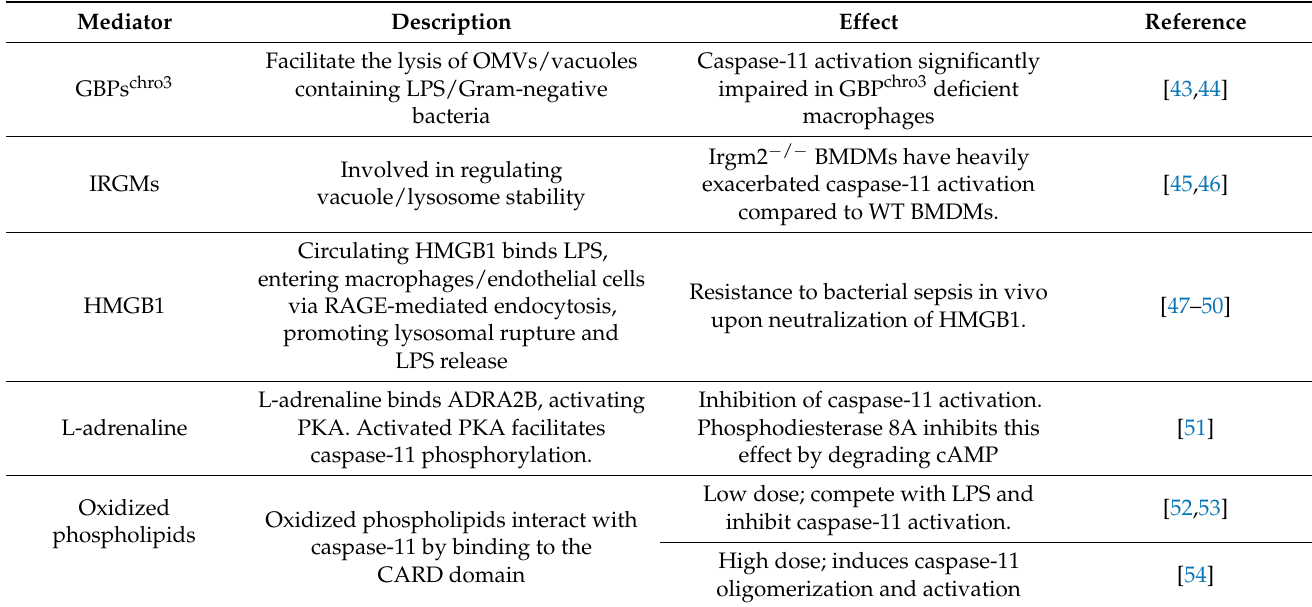
Table 2. Regulators of Caspase-11